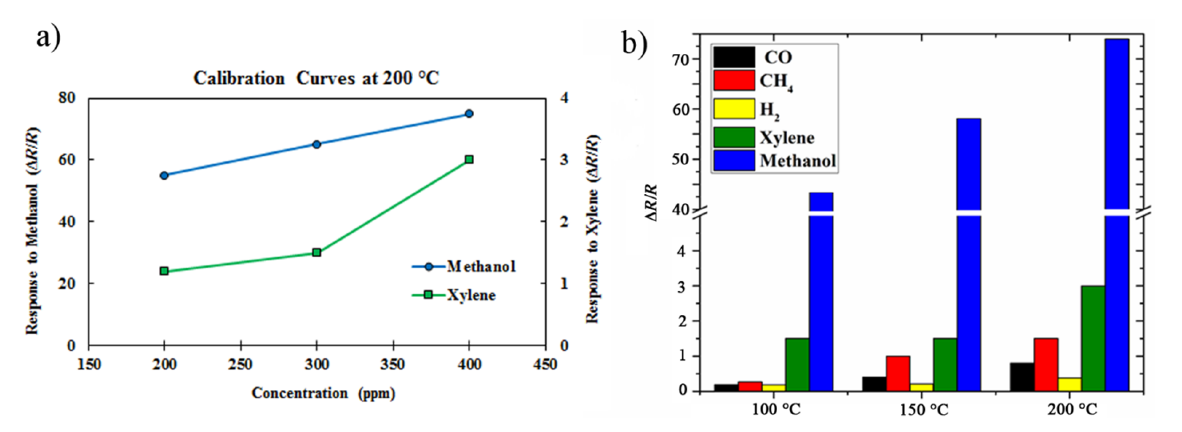
Figure 6: ( a) Calibration curves of flower-shaped MoS 2 nanoflakes towards xylene and methanol at 200 °C; (b) the sensitivity of the samples towards 400 ppm of CO, CH 4 , H 2 , xylene, and methanol at different working temperatures.